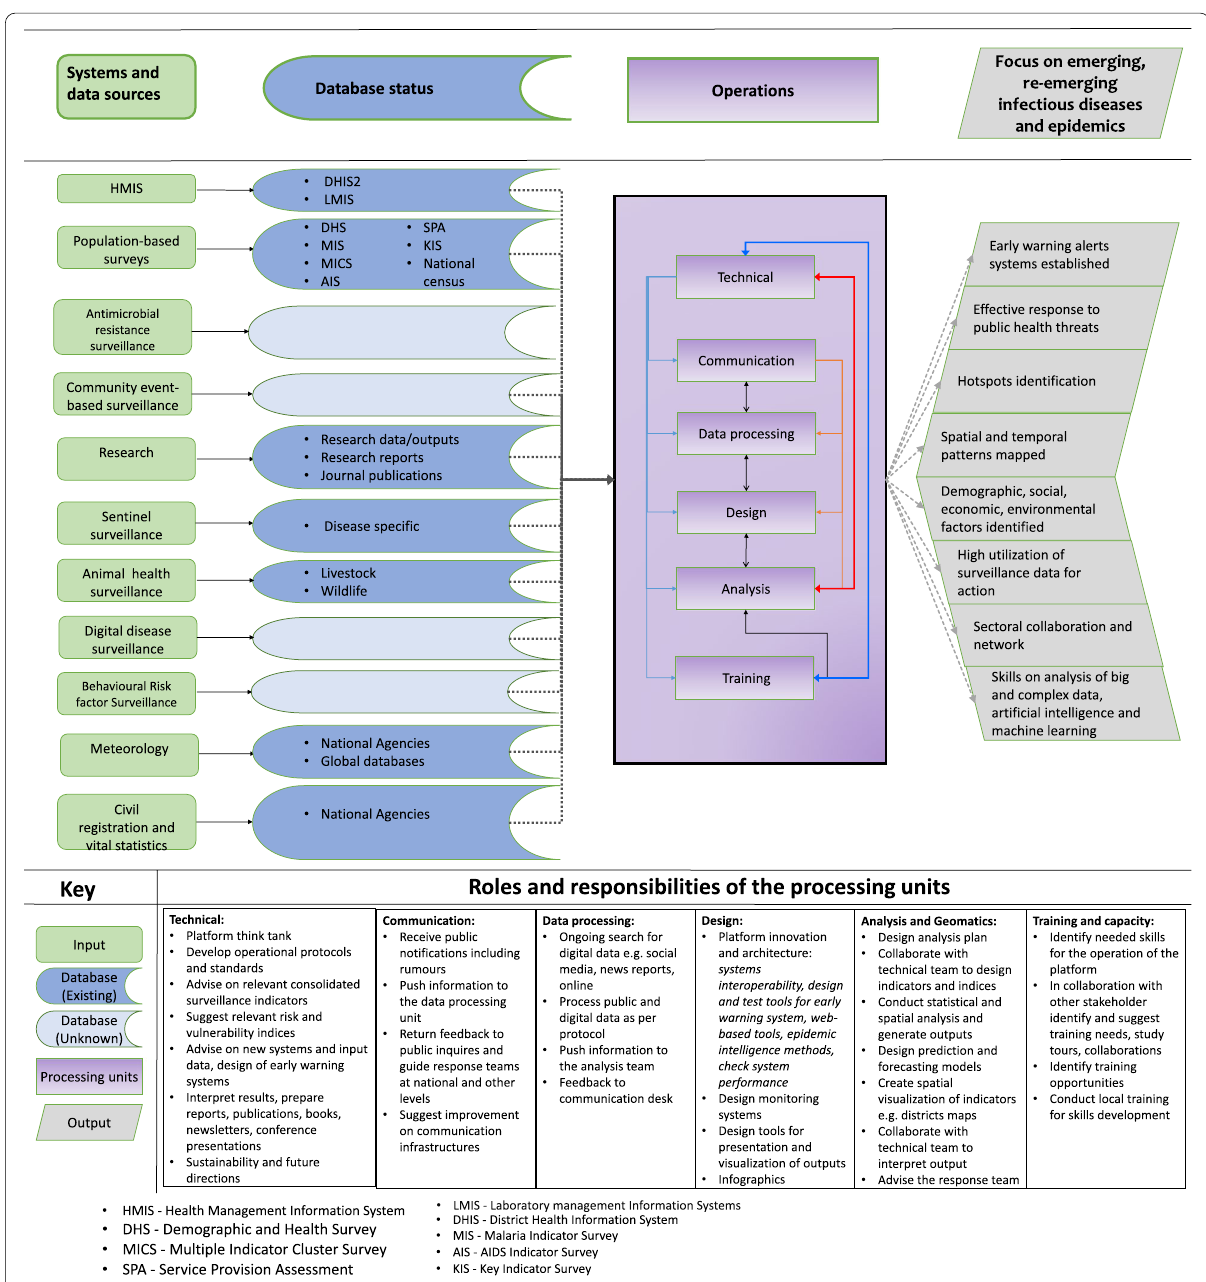
Fig. 2 National Platform for a Multi-Sectoral, Multi-Disease and Multi-Indicator (3Ms) Epidemic Intelligence